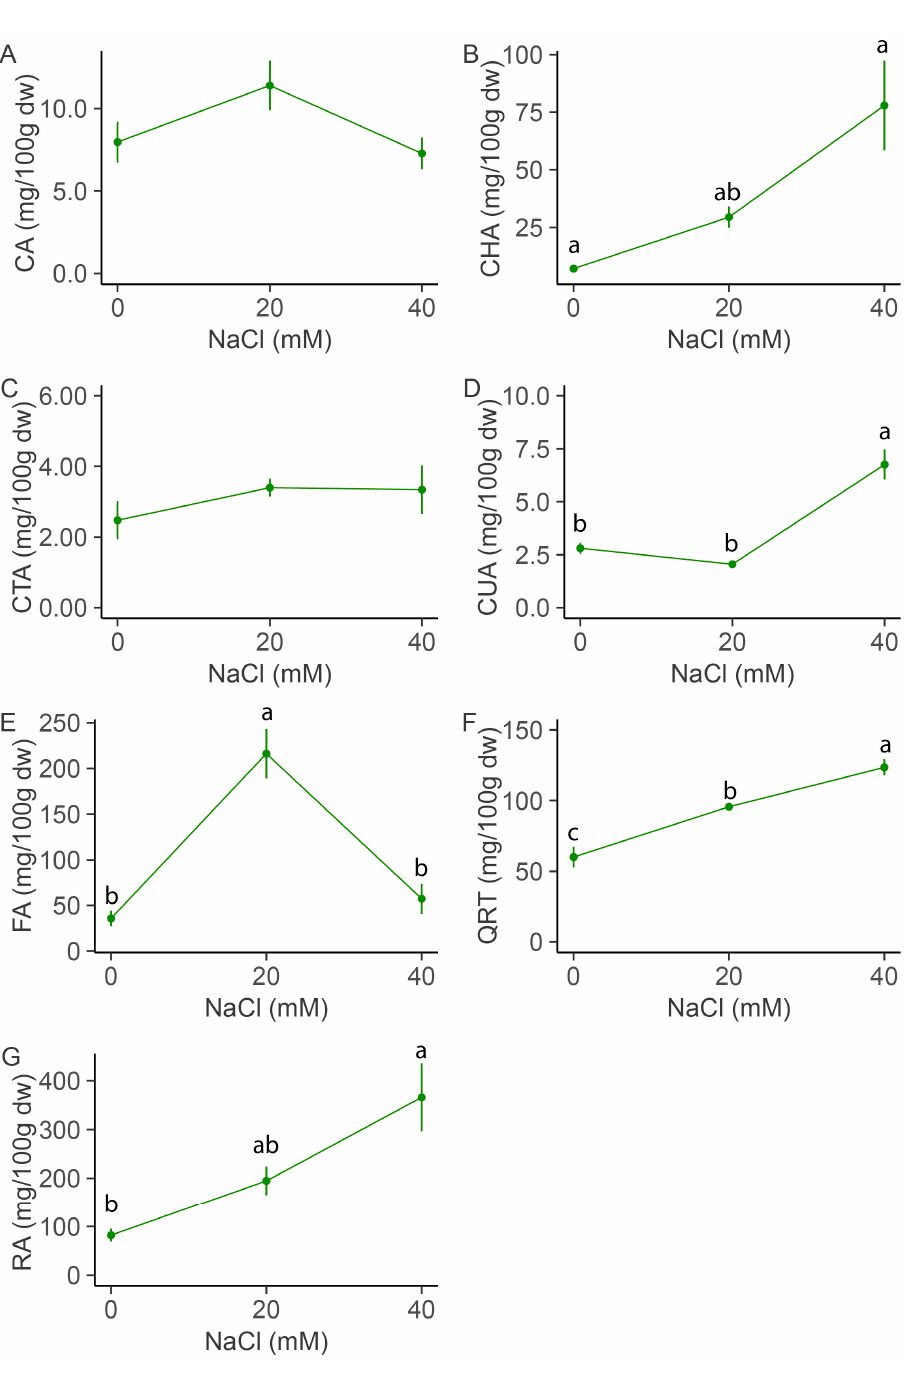
Figure 5. Effects of the NaCl in the nutrient solution on the polyphenolic compounds in leaves: ( A ) caffeic acid (CA); ( B ) chicoric acid (CHA); ( C ) caffeoyltartaric acid (CTA); ( D ) p -coumaric acid (CUA); ( E ) ferulic acid (FA); ( F ) quercetin rutinoside acid (QRT); ( G ) rosmarinic acid (RA). Data are mean ± standard error of the mean. Different letters indicate significantly different means according to the Tukey HSD test ( p < 0.05).